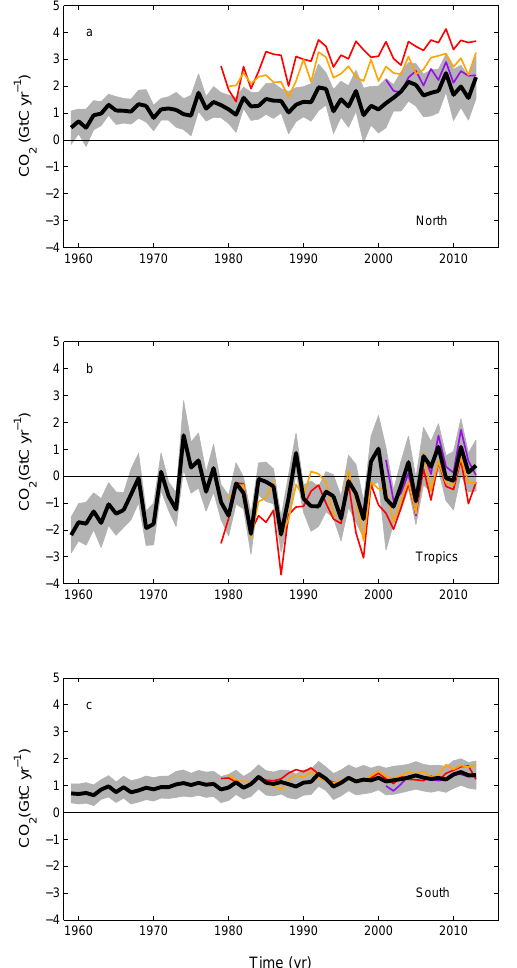
Figure 8. Surface CO 2 flux by latitude bands for the north (top panel, north of 30 ◦ N), tropics (middle panel, 30 ◦ S–30 ◦ N), and south (south of 30 ◦ S). Estimates from the combination of the multi- model means for the land and oceans are shown (black) with ± 1 σ of the model ensemble (in grey). Results from the three atmospheric inversions are shown (MACC, v13.1 (Chevallier et al., 2005) in red; Rödenbeck et al. (2003) in orange; Peters et al. (2010) in purple; Table